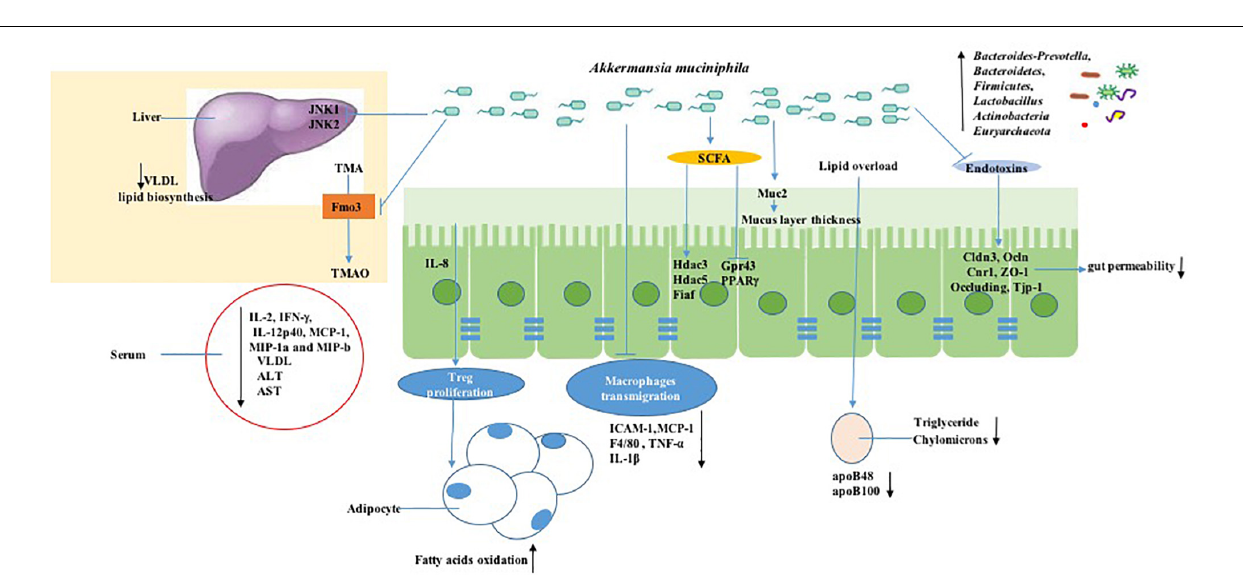
FIGURE 3 | Mechanisms of signaling due to A. muciniphila action in obesity. A. muciniphila can decrease the serum level of inflammatory cytokines such as IL-2, IFN- γ , IL-12p40, and MCP-1. Meanwhile, A. muciniphila decreases the lipid overload process associated with the LDL receptor pathway by decreasing apoB48 and apoB100 on LDLs. Moreover, short-chain fatty acid production stimulated by A. muciniphila is involved in signaling to the host by inhibiting histone deacetylase (HDAC) or by activating G-protein-coupled receptors, which triggers other metabolic pathways, together resulting in immune stimulation including macrophage transmigration and Treg proliferation changes. A. muciniphila regulates the intestinal permeability and gut barrier by tight-junction proteins such as Claudin 3 (Cldn3), Occludi(Ocln), and Cannabinoid Receptor 1 (Cnr1) and reverses the high enzyme expression of flavin-containing monooxygenase 3 (FMO3), which modulates TMA conversion into TMAO in the